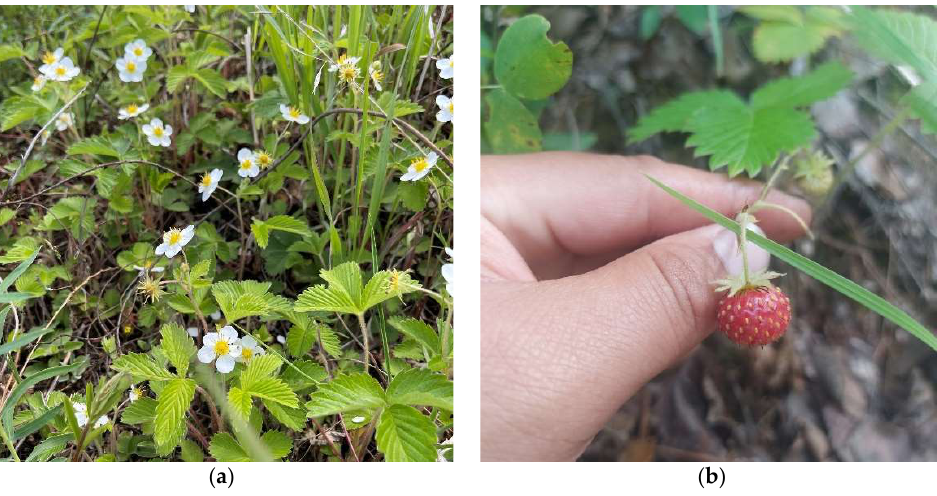
Figure 1. Fragaria orientalis Losinsk (oriental strawberry) flowering plants ( a ) and fruit ( b ). At the same time, in recent decades, agriculturists and breeders have conducted active research on F. orientalis domestication, which has led to the creation of some varieties that demonstrated high productivity [15]. In a collection nursery, when transferred from the local flora, F. orientalis acclimatizes very quickly (within 2 years), and its development significantly exceeds that of the wild one. In its cultivated forms, the bush of the second year of fruiting is powerful (up to 35 cm or higher), densely leafy, and has a vertical hab- itus. The beginning of maturation is 1–3 July, which is 10–14 days ahead of wild-growing forms. The average yield per bush is 165 g, and the maximum yield is more than 200 g. The mass of berries in the first collection exceeds those of wild varieties (5–11 g/berry),